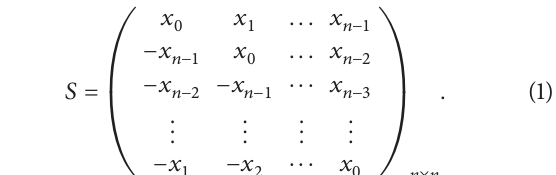
algorithm for optimal design of block digital filters